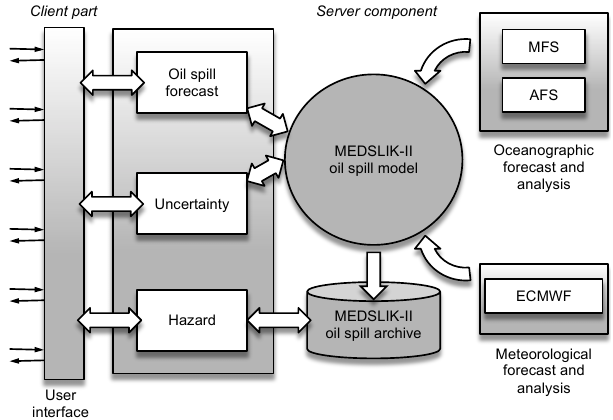
Figure 1. Schematic structure of the WITOIL